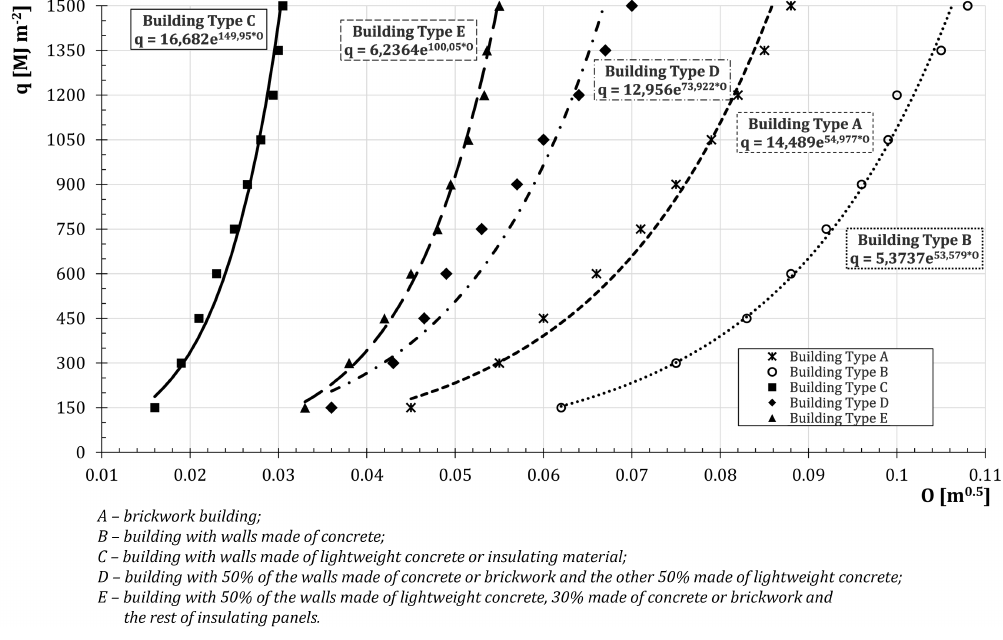
Figure 6. Threshold curves revealing the importance of planning fire protection measures for standard fires in civil buildings characterized by cellulosic